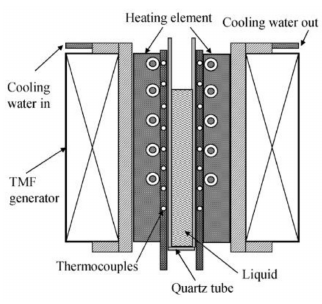
Figure 1. The schematic illustration of the experimental apparatus.